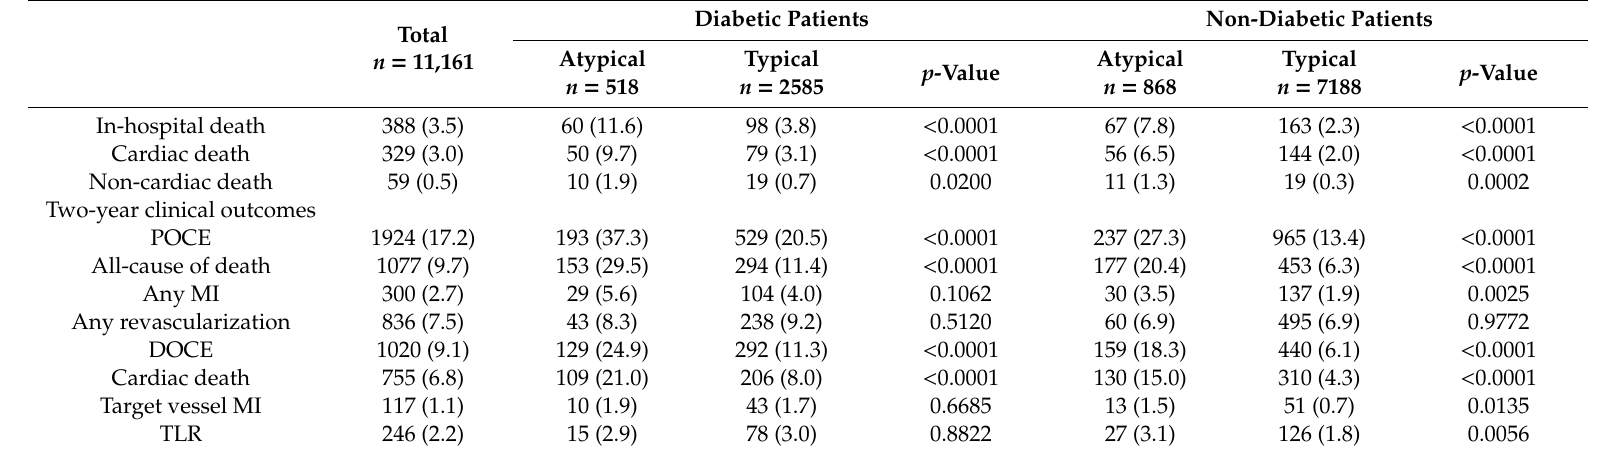
Table 3. In-hospital death and 2-year clinical